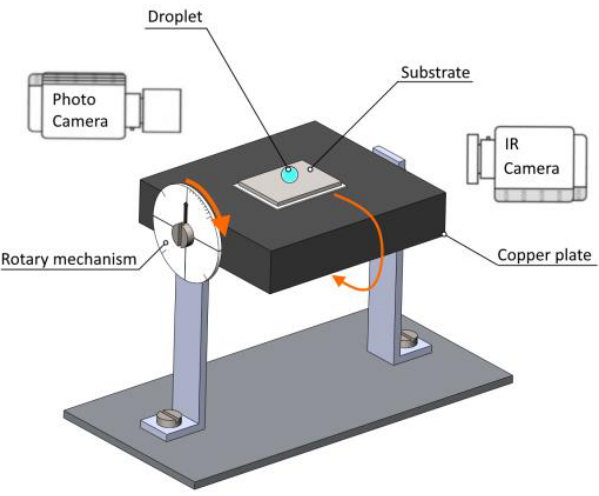
Figure 2. Schematic of the experimental setup. We studied droplets of distilled water with an initial volume of about 6 µ L. The ambient temperature and relative humidity corresponded to room-temperature conditions and were 25 ◦ C and ϕ = 21%, respectively. Droplets were formed on the substrate surface using a Thermo Scientific mechanical pipette with an accuracy of ~0.1 µ L. The temperature distribution on the droplet surface was determined by infrared thermography (Figure 3a,b). The measurements were carried out with an NEC TH7102IR thermal imaging camera at wavelengths of λ = 8–14 µ m using a TH 71-377 macro lens. Thermal images were averaged over the area near the central part of the thermal image of the droplet, as shown in Figure 3a,b. The obtained data were processed by the ThermoTracer program. The systematic and random errors of these measurements were estimated at 0.2 ◦ C and 0.45 ◦ C, respectively, resulting in a total error of 0.65 ◦ C. During the experiment, the droplet shape was recorded with a Digi Scope II v3 digital microscope. The contact angle, contact line size, and droplet height were measured from the photographs as shown in Figure 1c,d. The contact angle was measured on the left and right sides (see Figure 1d), and the obtained values were then averaged. Each evaporation experiment was repeated 3 times and good reproducibility of all geometric parameters was observed. The error in the determination of the geometric parameters was the sum of the instrumental error (0.05 mm) and the statistical error (0.02 mm). The change in the shape of the evaporating droplets is shown in the photographs (Figure